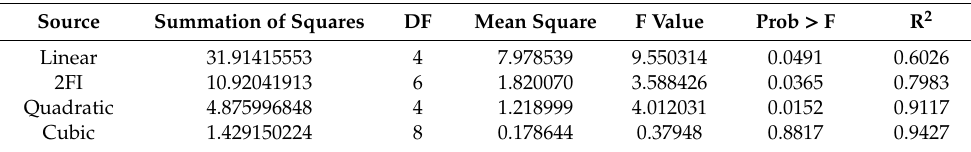
Table 3. Chronological model summation of squares.